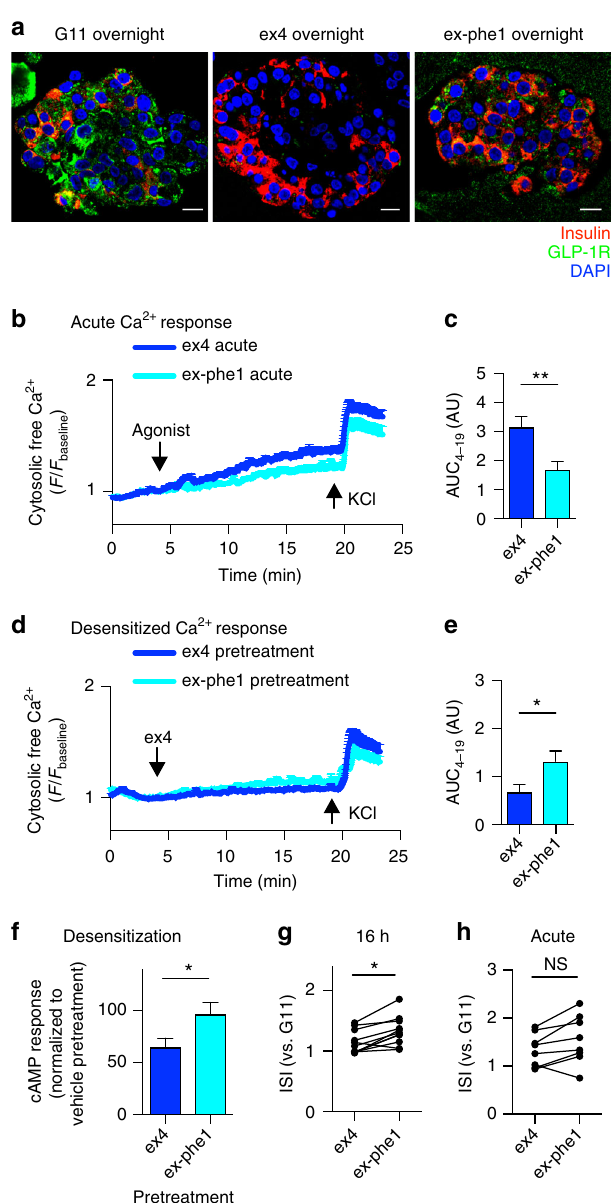
Fig. 7 Effects of exendin-phe1 in human islets. a Residual human islet surface GLP-1Rs labeled with exendin-4-FITC after overnight treatment with G11 ± agonist, representative image from n = 3 donors; scale bars, 10 μ m. Individual red and green channels shown in Supplementary Fig.